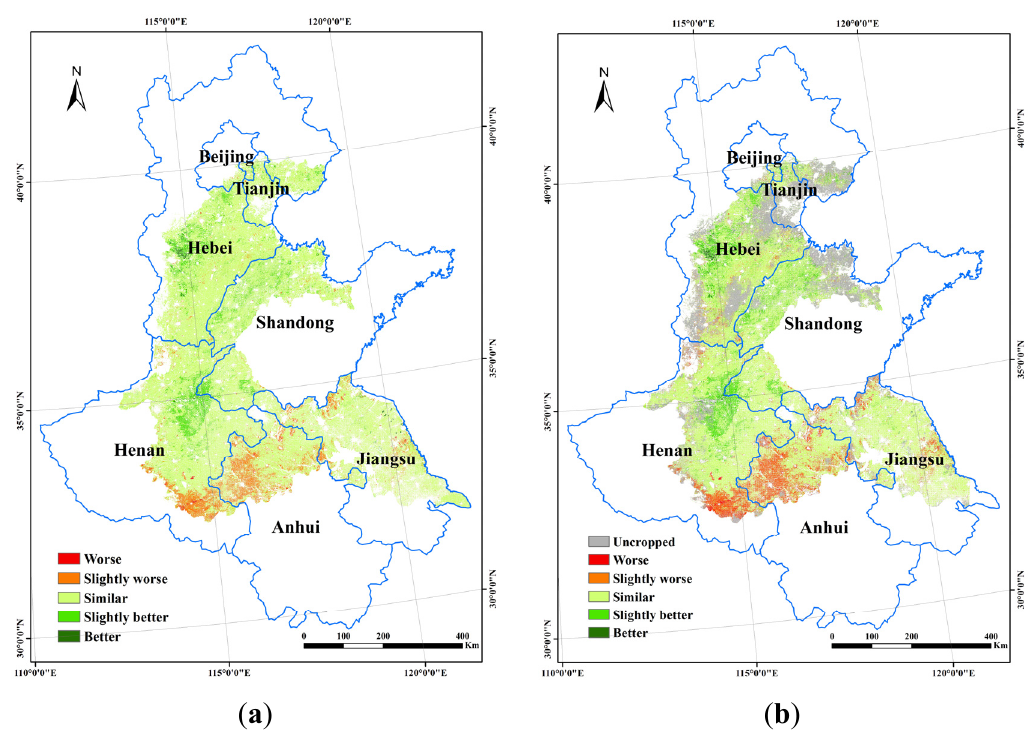
Figure 9. Crop condition map of NCP using MODIS NDVI ( a ) and UALR-adjusted NDVI; ( b ) for early May 2011. The maps show the condition of the crop compared to the previous